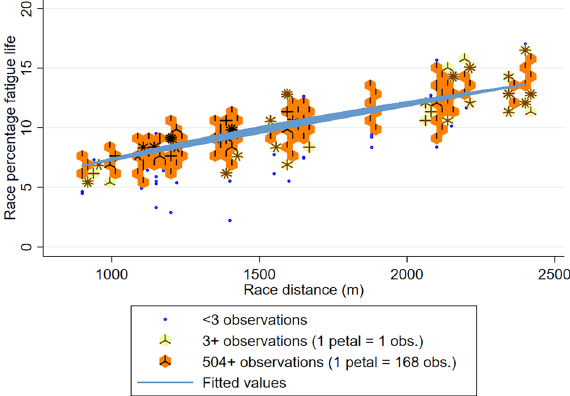
Figure 2. Scatter density plot of race distance to the percentage of fatigue life accrued per race with Box- Tidwell power transformed fitted linear regression line from the final multivariable model (transformed race distance = race distance per 100 m 0.353 ). Petals of shaded areas (“sunflowers”) represent the number of observations, where the number of observations increase from blue (< 3 observations) to shaded sunflowers of yellow (3 to 503 observations) to orange (504 + observations). Overlapping lines (indicating greater number of overlapping petals) equate to the highest density regions within each sunflower.